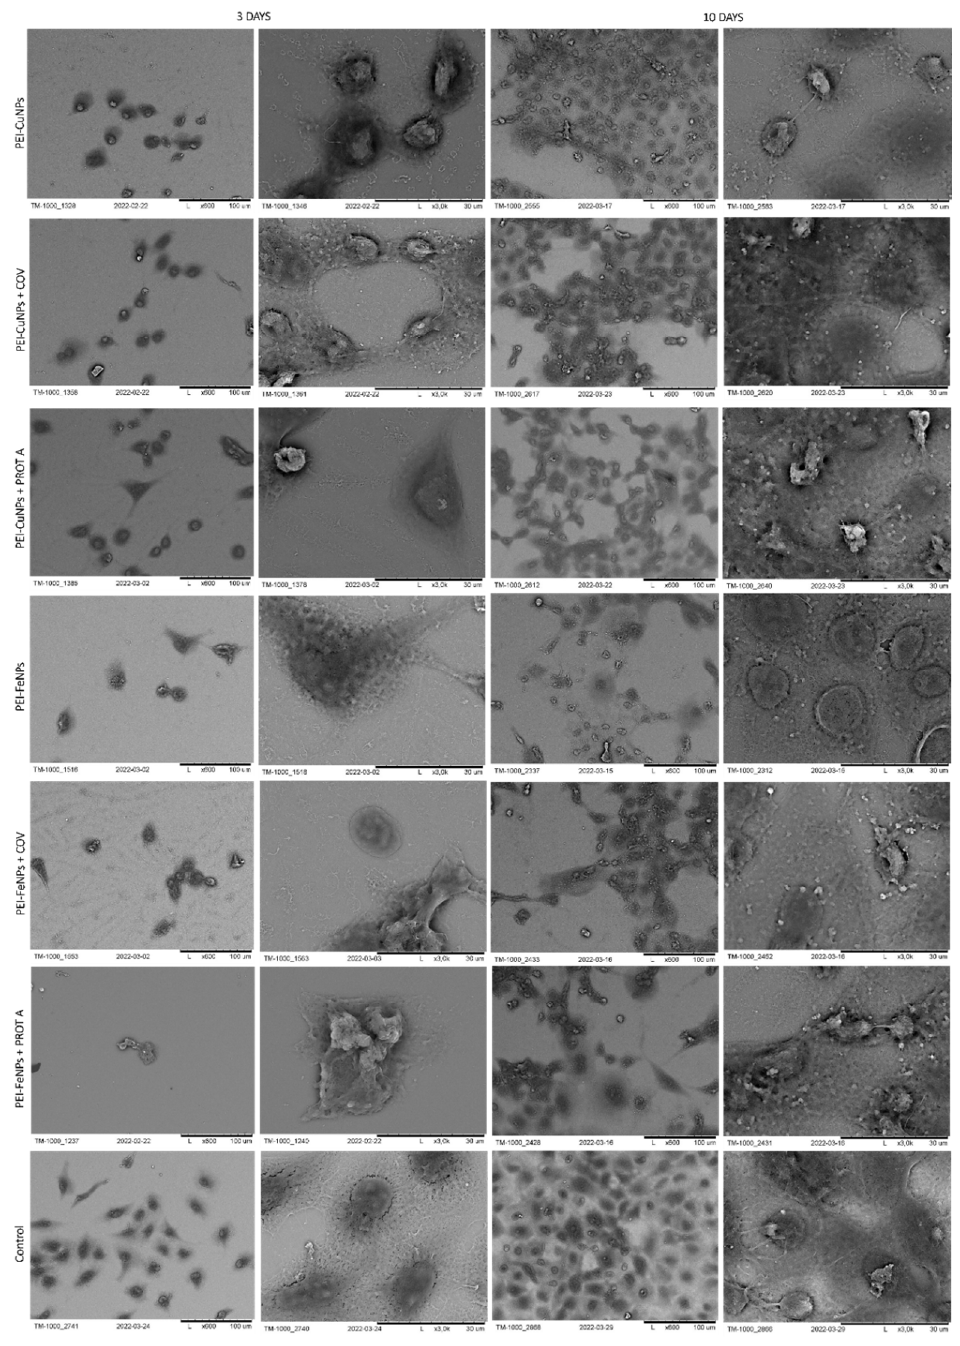
Figure 7. SEM visualization of A549 cells adsorbed within designed membranes after a 3- or 10-day culture. As a control, served cells cultured on glass slides without the membranes. Key to the sym- bols: PEI-AuNPs: the membrane build of the polyethylenimine with AuNPs incorporated; PEI- CuNPs: the membrane build of the polyethylenimine with CuNPs incorporated; PEI-CuNPs + COV: the membrane build of the polyethylenimine with CuNPs incorporated with adsorbed COV; PEI- CuNPs + PROT A: the membrane build of the polyethylenimine with CuNPs incorporated with adsorbed Protein A; PEI-FeNPs: the membrane build of the polyethylenimine with FeNPs incorpo- rated; PEI-FeNPs + COV: the membrane build of the polyethylenimine with FeNPs incorporated with adsorbed COV; PEI-FeNPs + PROT A: the membrane build of the polyethylenimine with FeNPs incorporated with adsorbed Protein A.